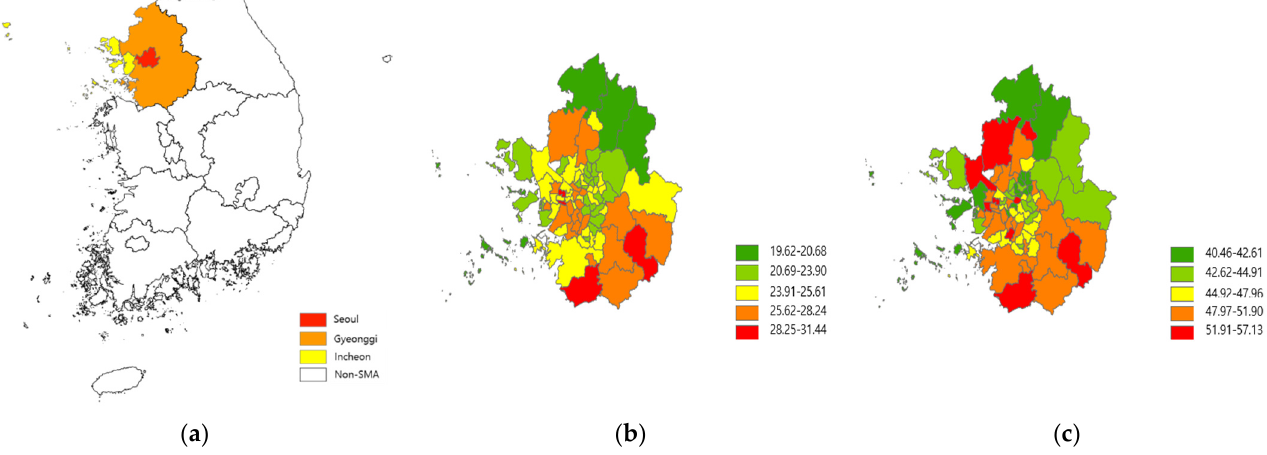
Figure 1. Maps of South Korea and the Seoul Metropolitan Area ( a ), and PM 2.5 ( b ) and PM 10 ( c ) concentrations ( μ g/m 3 ) for 2015–2019.